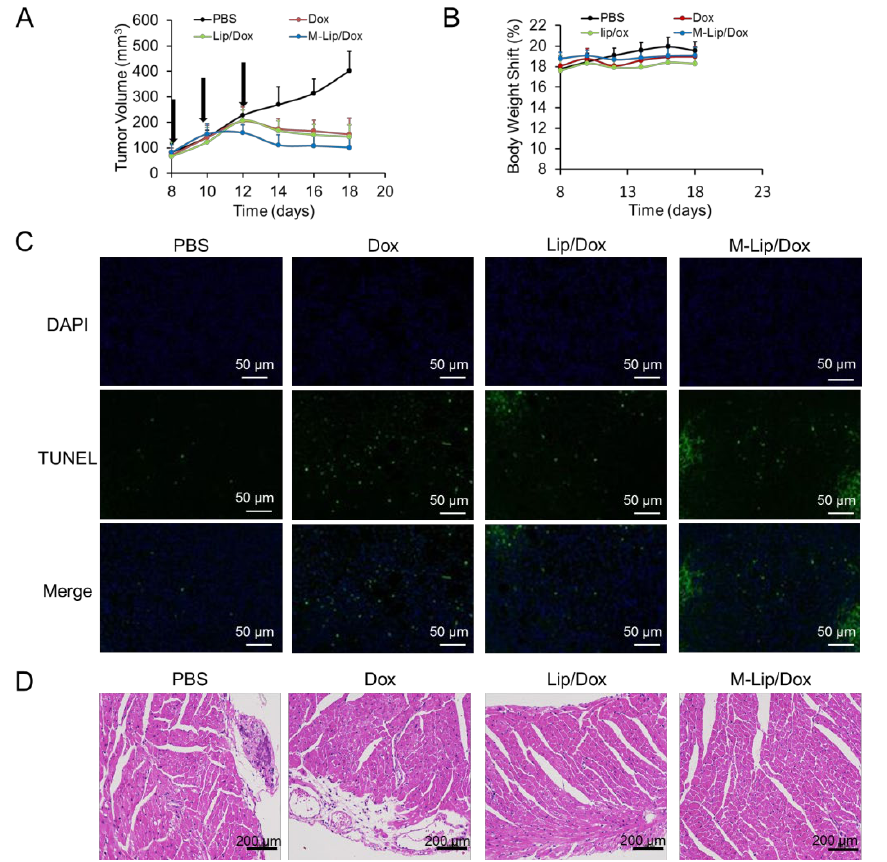
Figure 4. Xenograft-bearing mice were treated with different formulations (4 mg Dox/kg). ( A ) Tu- mor volume. ( B ) Body weight. ( C ) Representative TUNEL-DAPI photomicrographs of tumor tissues at 18 days after in situ injection of PBS, free Dox, Lip/Dox, or M-Lip/Dox. DAPI (blue) was used to label nuclei; TUNEL stain (green) to label apoptotic cells. ( D ) Histopathological analysis of the heart of mice treated with PBS, free Dox, Lip/Dox, or M-Lip/Dox. Data are shown as ± SD (n = 7). DAPI, 4′,6 -diamidino-2-phenylindole; Dox, doxorubicin; Lip/Dox, Dox-loaded liposomes; M-Lip/Dox, ma- leimide-functionalized Dox-loaded liposomes; TUNEL, terminal deoxynucleotidyl transferase dUTP-biotin nick-end labeling.